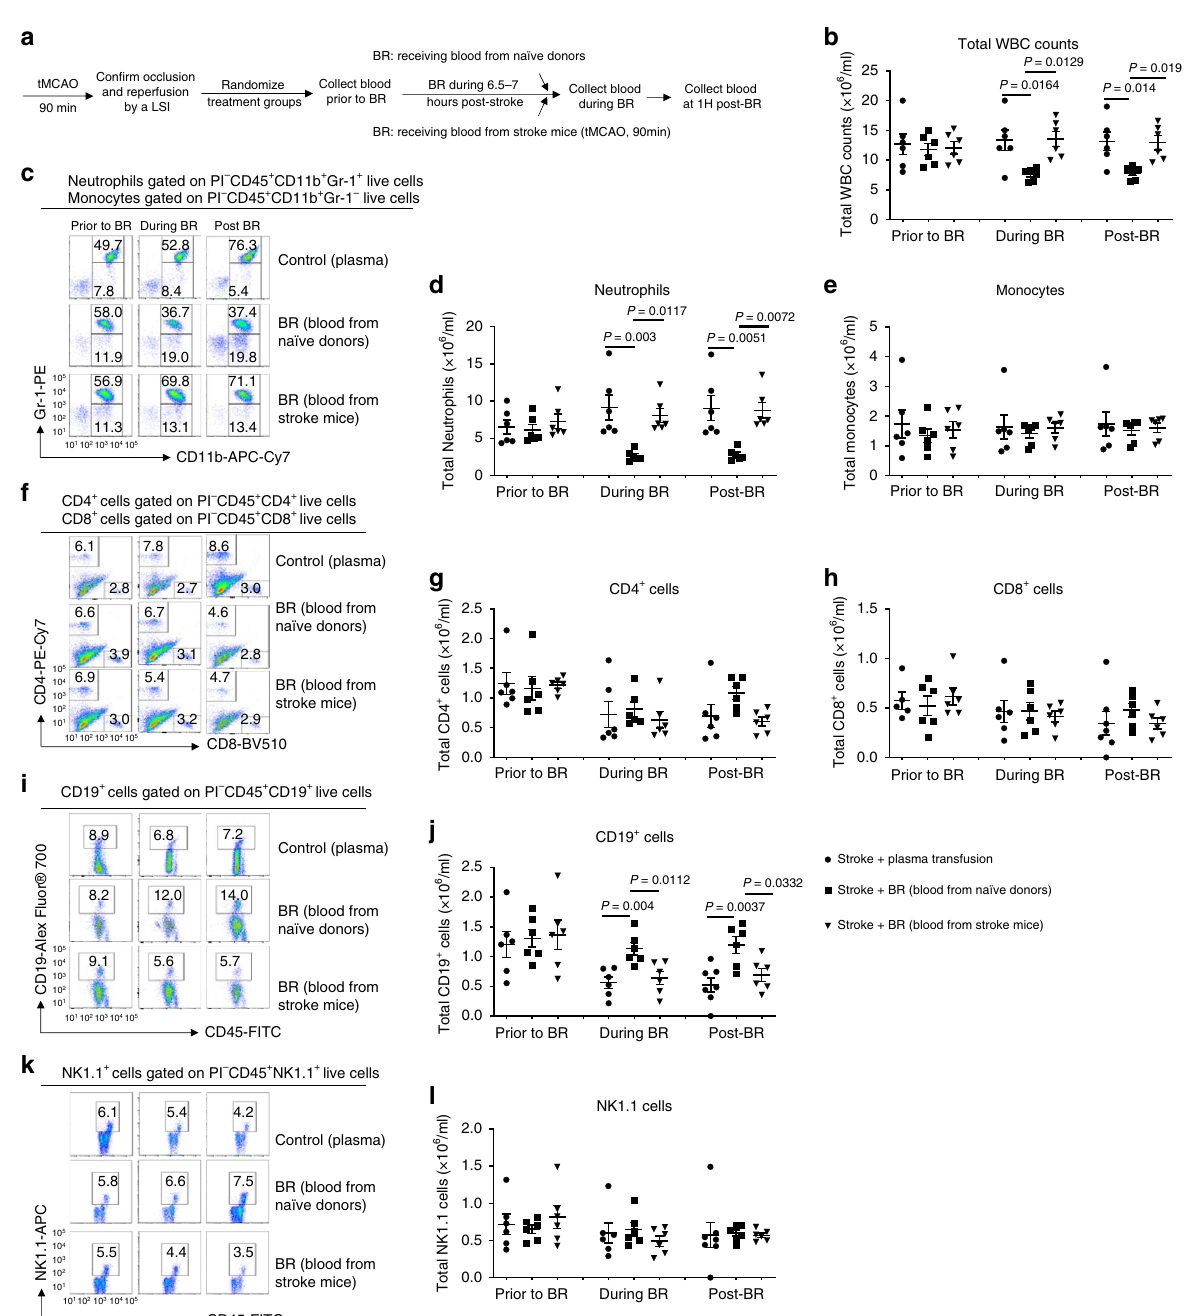
Fig. 4 Blood replacement therapy alters cellular pro fi les in blood of stroke mice. a Experimental design. Mice (8 months old males) underwent tMCAO for 90 min. The occlusion and reperfusion were con fi rmed by laser speckle imager (LSI). Mice were randomized into three groups: receiving 500 µ l of plasma (circles, n = 6) from healthy donors, 500 µ l of blood from healthy donors (squares, n = 6), and 500 µ l of blood from stroke mice (90 min tMCAO followed by 4.5 h reperfusion) (triangles, n = 6). Blood was transfused into stroke mice at 6~8 h post stroke. The same volume of blood was withdrawn from the recipient stroke mice during blood transfusion. Blood obtained from recipient stroke mice were analyzed at three time points: prior to blood replacement (BR), during BR, and at 1 h post BR. b Total white blood cells were counted. c Representative fl ow cytometry images for neutrophils gated on propidium iodide (PI) − CD45 + CD11b + Gr-1 + populations and monocytes gated on PI - CD45 + CD11b + Gr-1 − populations. d Total neutrophil counts. e Total monocyte counts. f Representative fl ow cytometry images for CD4 + cells gated on PI − CD45 + CD4 + populations and CD8 + cells gated on PI − CD45 + CD8 + populations. g Total CD4 + cell counts. h Total CD8 + cell counts. i Representative fl ow cytometry images for CD19 + B-cells gated on PI − CD45 + CD19 + populations. j Total CD19 + B-cell counts. k Representative fl ow cytometry images for NK1.1 + cells gated on PI − CD45 + NK1.1 + populations. l Total NK1.1 + cell counts. Data were presented as means ± SEM. One-way ANOVA followed by post hoc Tukey ’ s test was used to determine the signi fi cance. Source data are provided as a Source Data fi